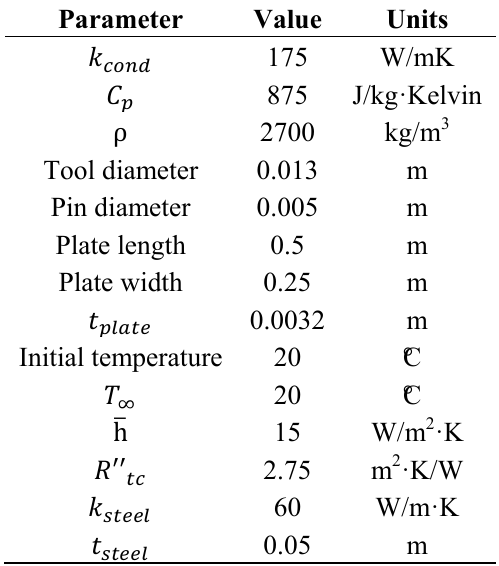
Table 1. Simulation